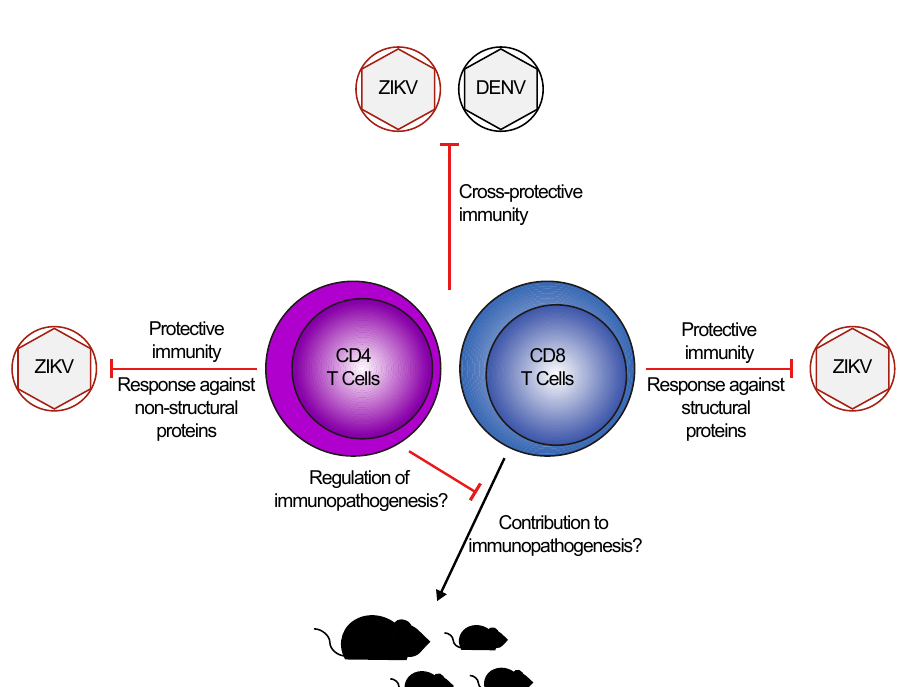
Figure 1. Zika virus (ZIKV) infection induces robust, cross-protective T cell immunity. In both humans and mice, ZIKV infection leads to the generation of Th1 CD4 T cell and e ff ector CD8 T cell responses, which preferentially target epitopes in non-structural and structural proteins, respectively. Studies have shown that immunity to ZIKV is cross-protective against subsequent Dengue virus (DENV) challenge, and vice-versa. Although studies suggest CD8 T cells may contribute to immunopathogenesis in neonatal and adult mice, with CD4 T cells playing a potential regulatory role, this remains to be determined during human infection.